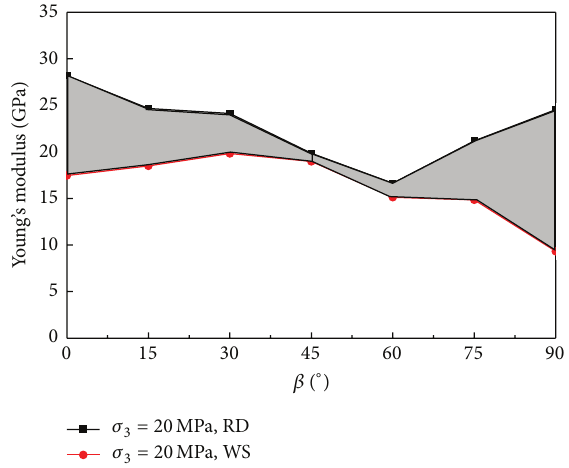
Figure 12: Comparison of the compressive strength of the room dried and water saturated specimens.